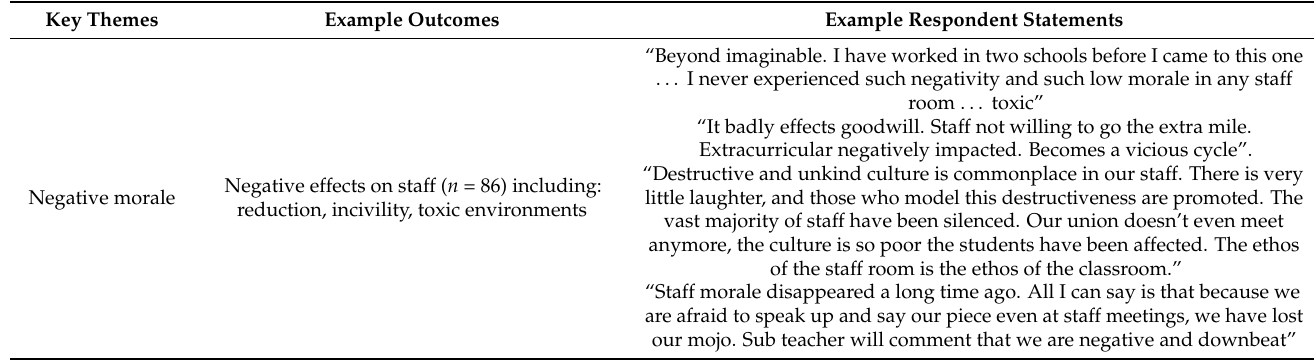
Table 10. Impact of toxic leadership on staff